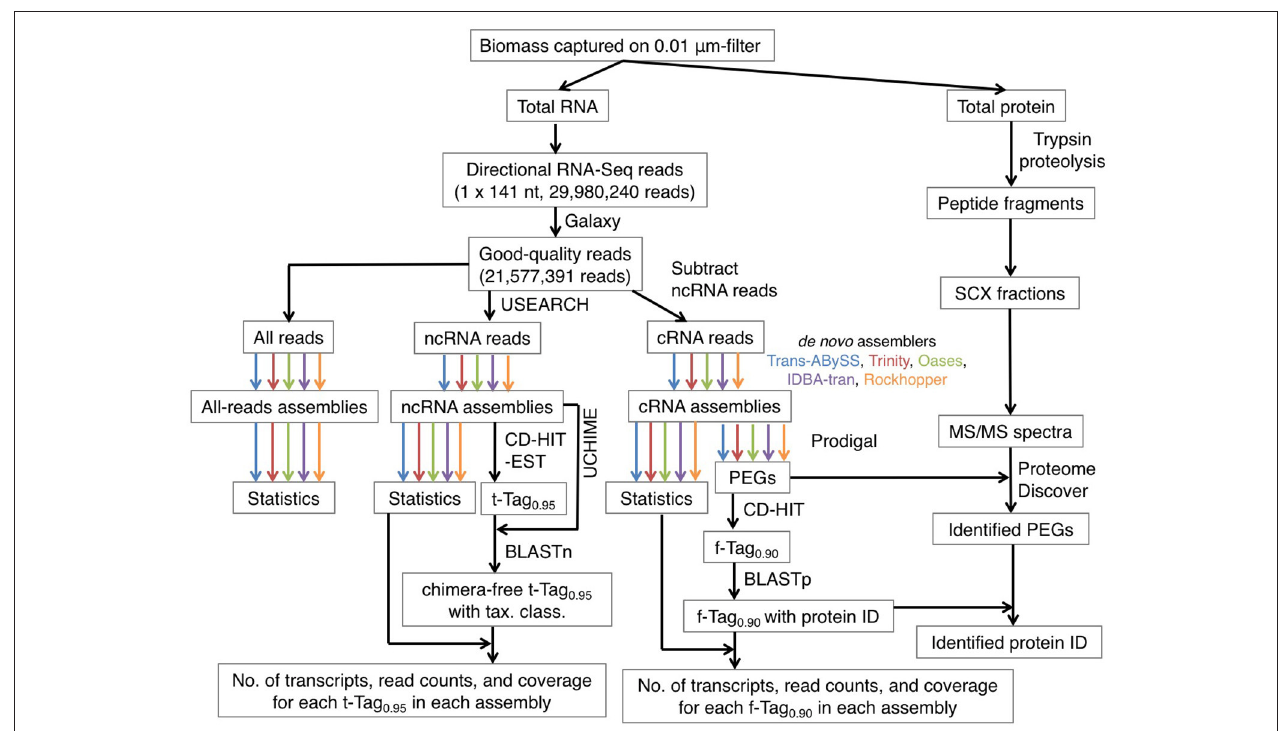
FIGURE 1 | An overview of the bioinformatics workflow. The color arrows indicate the generation of 15 assemblies using five de novo transcriptomic assemblers, namely Trans-ABySS (blue), Trinity (red), Oases (olive), IDBA-tran (purple), and Rockhopper (orange). Abbreviations: ncRNA, non-coding RNA; cRNA, coding RNA; tax. class., taxonomic classification; PEG, protein-encoding gene; protein ID, protein identity; SCX, strong cation exchange; MS/MS, tandem mass